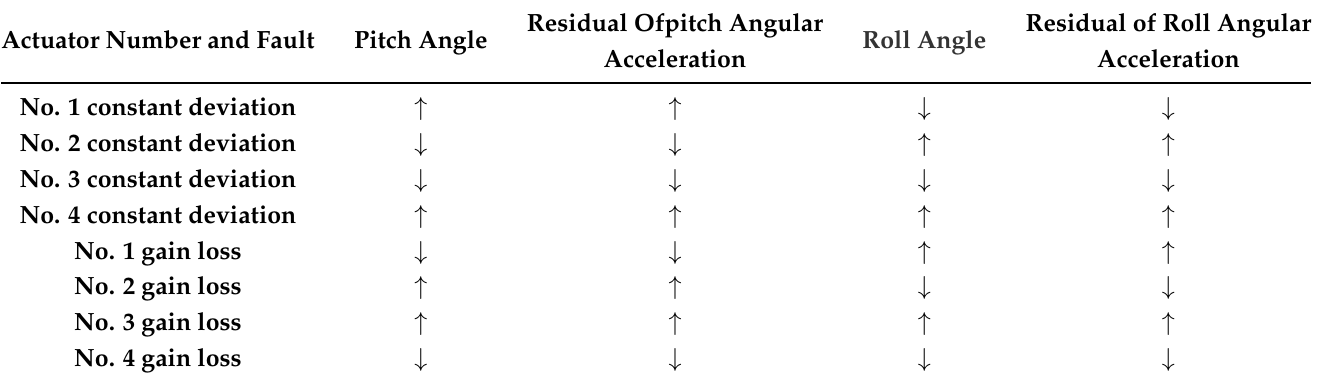
Table 1. The trend of each signal value change when the actuator fails. ↑ means the corresponding value increases, ↓ means the corresponding value